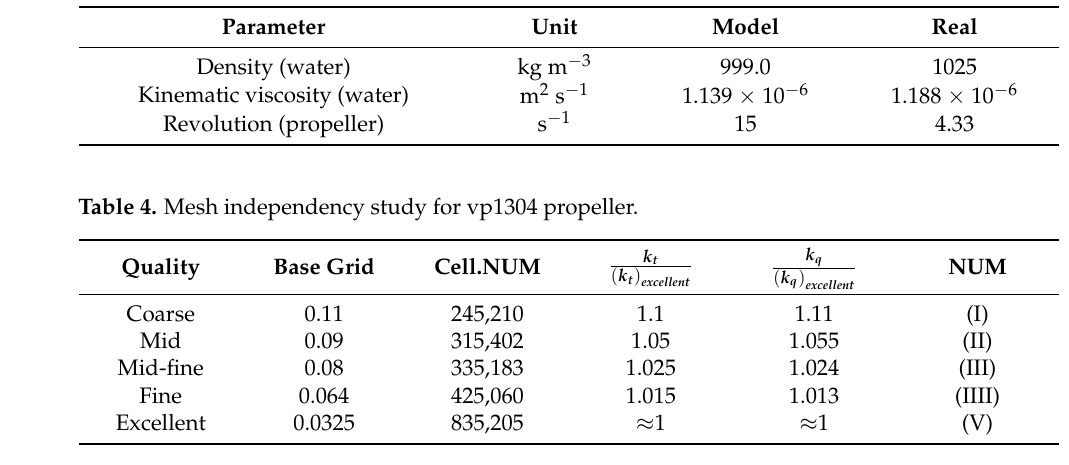
Table 4. Mesh independency study for vp1304 propeller.